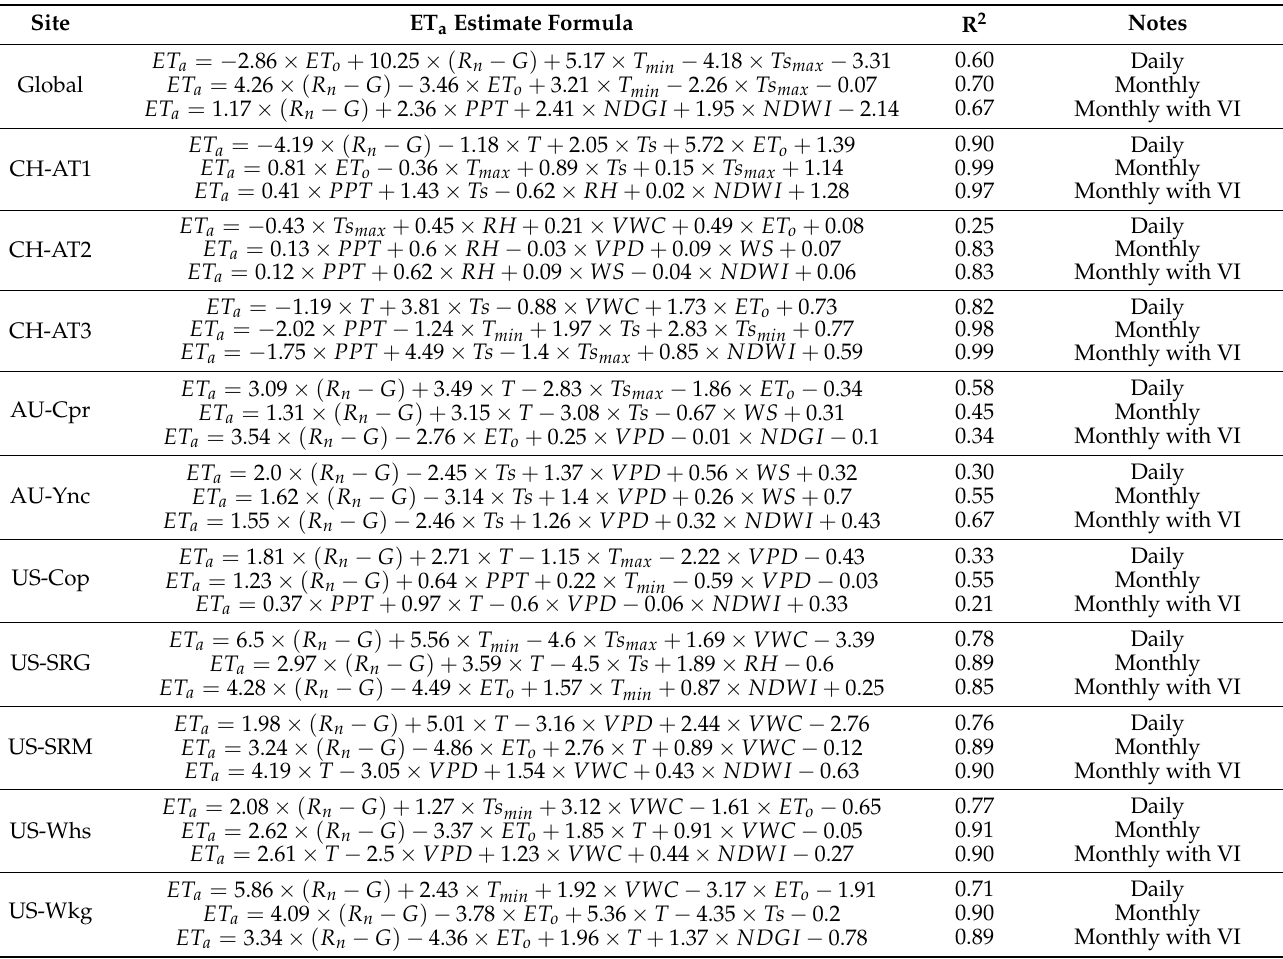
Table 5. Global and site-specific ET a estimate formulae obtained with the training data set, and their respective coefficient of determination. ET a is expressed in mm/day in all